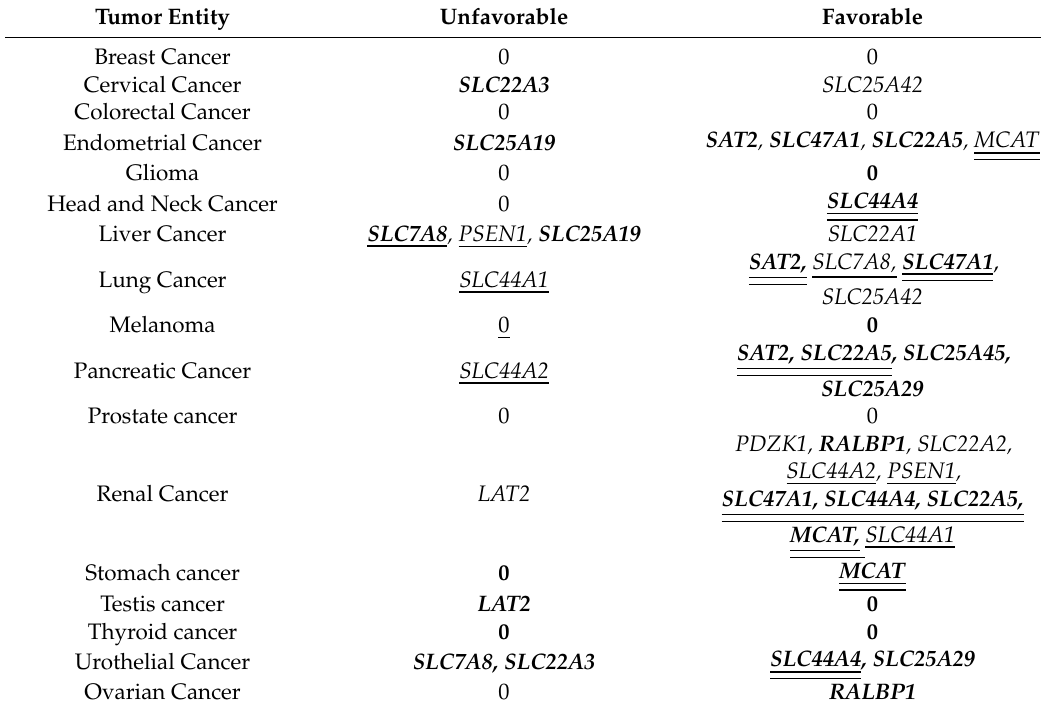
Table 2. Prognostic organic cation transport related genes identified in di ff erent tumor entities. Genes present in two di ff erent tumor entities are highlighted in bold and genes present in three tumor entities are double underlined. Genes that are favorable for a given tumor entity but unfavorable for another tumor entity are